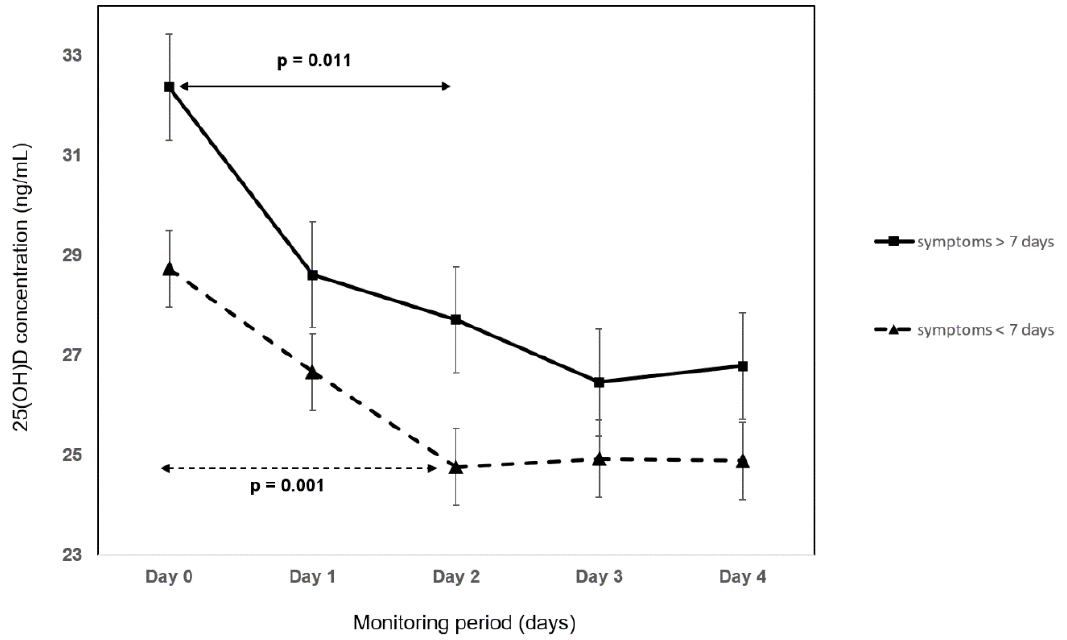
Figure 6. The kinetics of 25-hydroxyvitamin D (25[OH]D) concentration during hospitalization between shorter and longer duration of symptoms than median (median = 7 days).